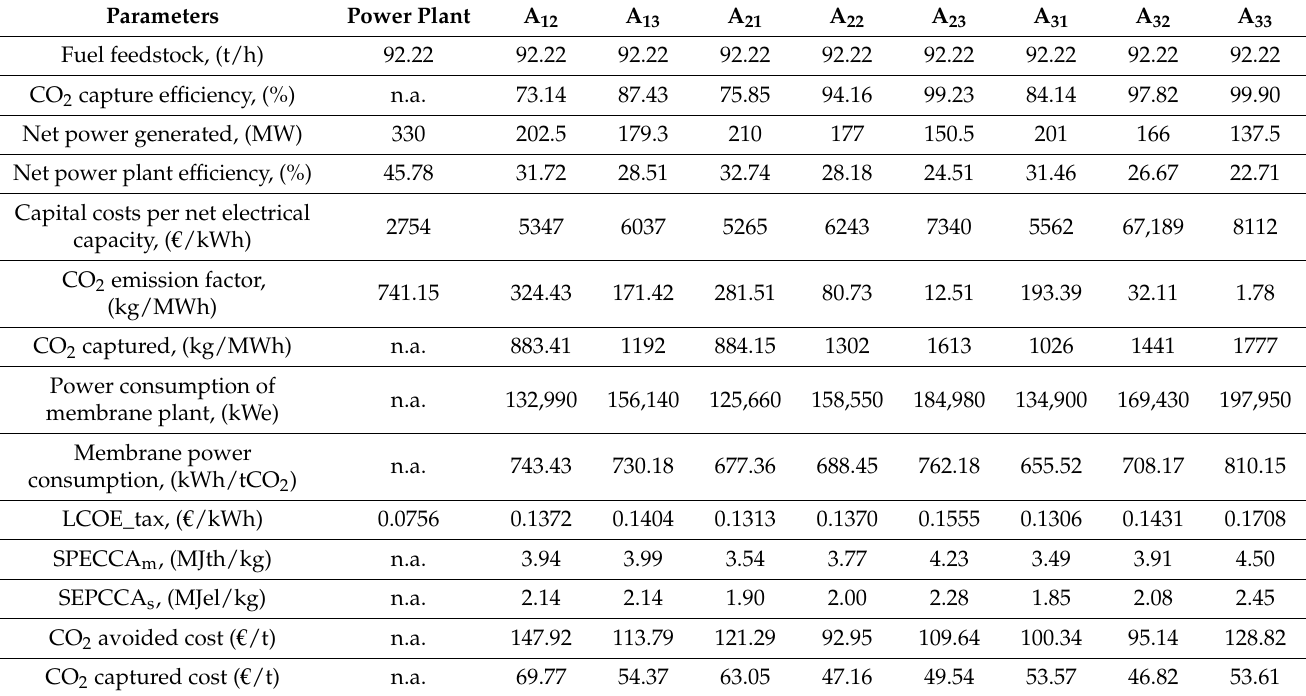
Table 10. The evaluation of the CFPP system with a single-stage of membrane technology (no vacuum pump used).